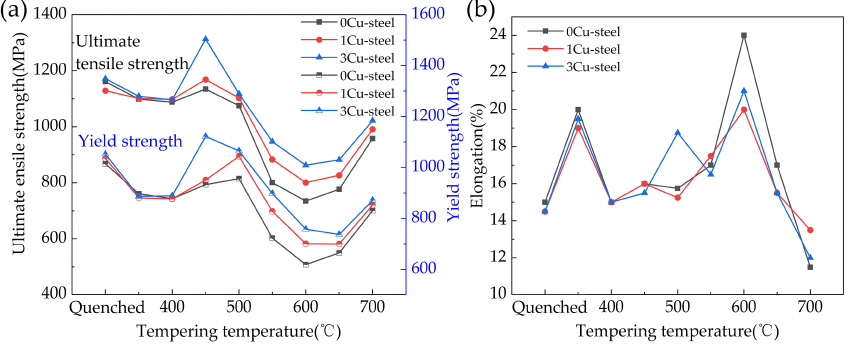
Figure 2. Effect of quenching and tempering temperatures on the mechanical properties of 0Cr13Ni4Mo steels with different Cu content: ( a ) ultimate tensile strength and yield strength; ( b )